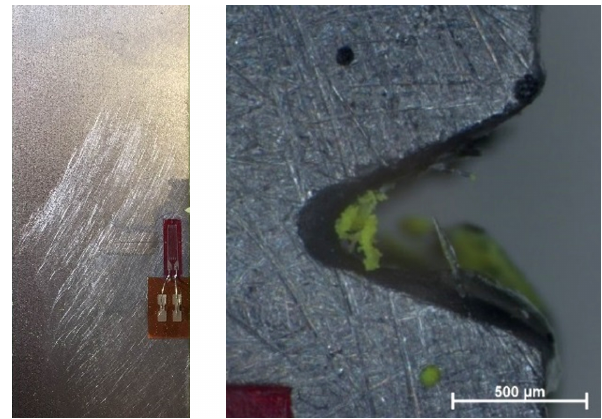
Figure 4. Metal sheet specimen with notch; a strain gauge was ap- plied